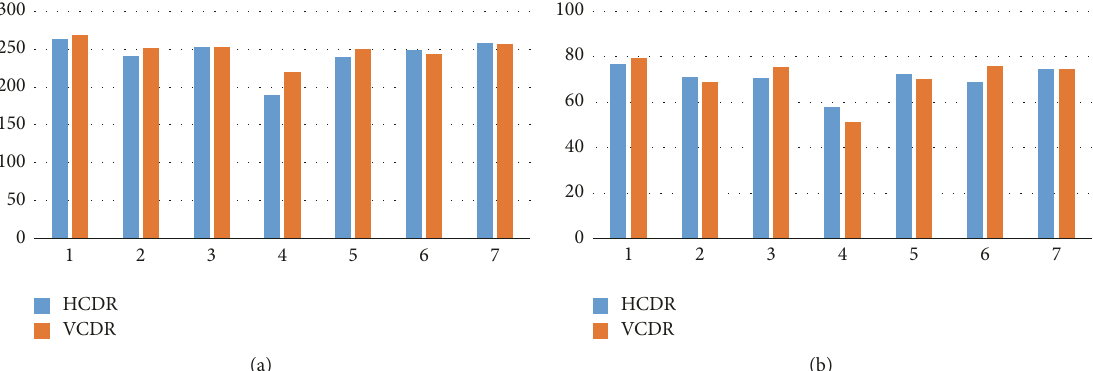
Figure 20: The results of HCDR and VCDR: (a) number of the accepted images (passing the image filtration process of the three parameters); (b) percentage accuracy.